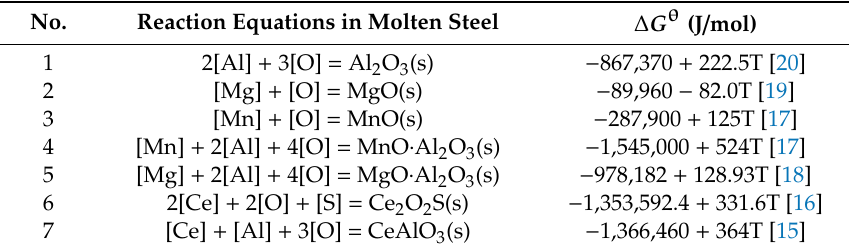
Table 4. Possible chemical reactions in steel and its standard Gibbs free energy.